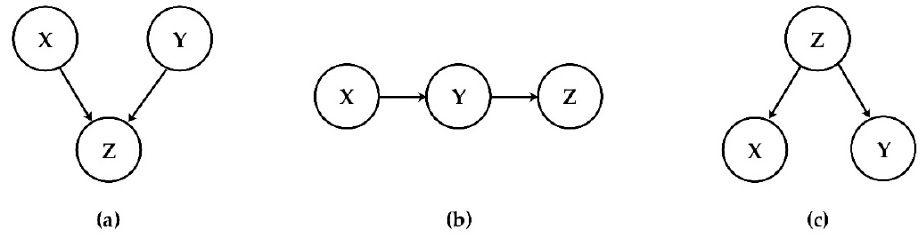
Figure 3. Three basic structures of Bayesian networks. ( a ) Head to head; that is, given the condition of Z, the communication between X and Y is blocked, also known as head-to-head condition independence. It is obvious that variables X and Y have a common result Z. The joint probability can be expressed as P (X, Y, Z) = P(X) P(Y) P (Z | X, Y). ( b ) Head to tail. For a given condition of Y, the communication between X and Z is blocked, which is called head-to-tail condition independent. X, Y, and Z are connected serially, and the corresponding joint probability distribution is P (X, Y, Z) = P(X) P (Y|X) P(Z|Y). ( c ) Tail to tail. For a given condition of Z, the communication between X and Y is blocked, which is called tail-to-tail condition independence. Obviously, X and Y have a common cause. The joint probability is therefore calculated as P (X, Y, Z) = P (Z) P (X|Z) P (Y|Z).